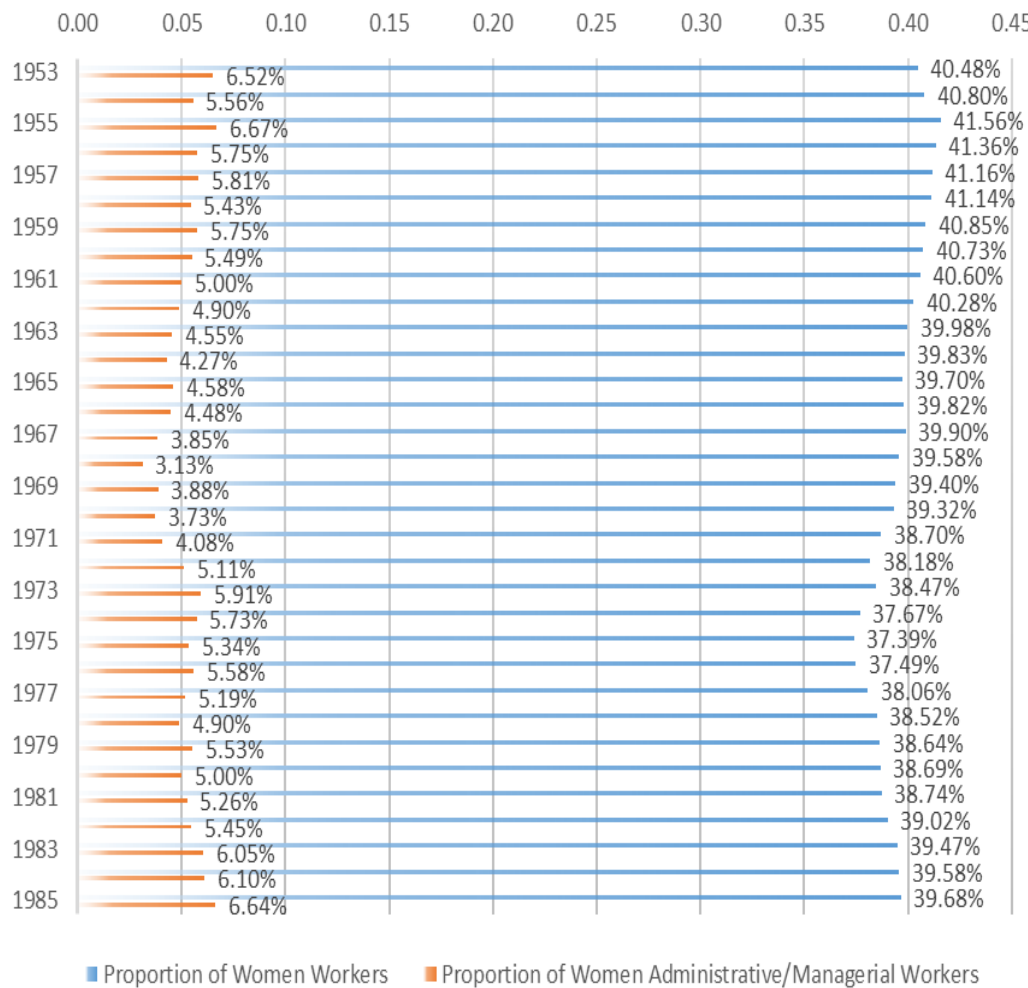
Figure 4. Proportion of Women Overall Workers and Women Administrative/Managerial Workers